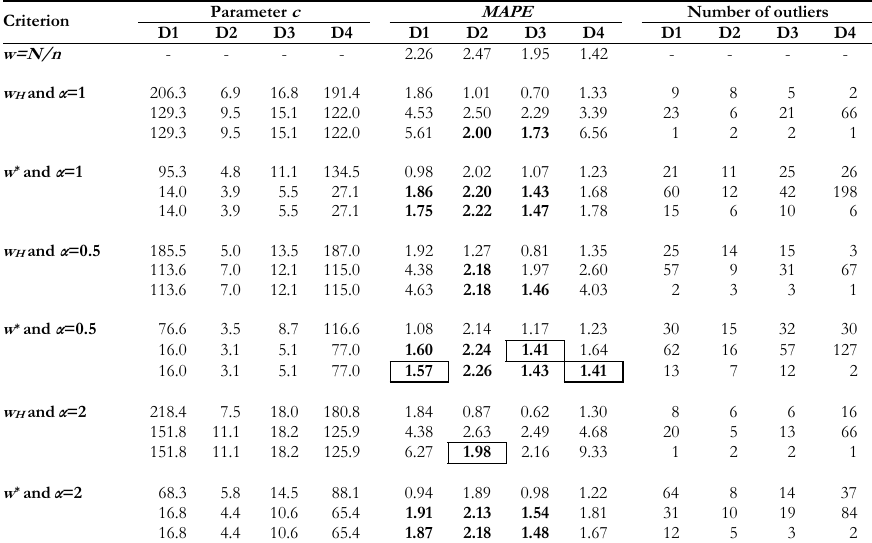
Comparison among estimation strategies – Average of monthly 2007 estimates for the retail trade